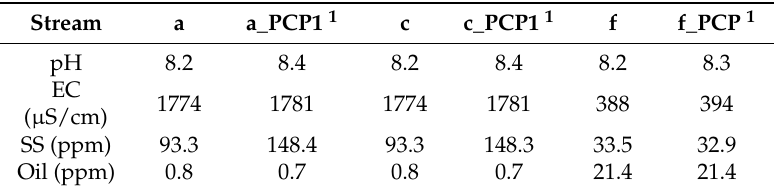
Note: 1 PCP1 indicates the reuse of PCP1